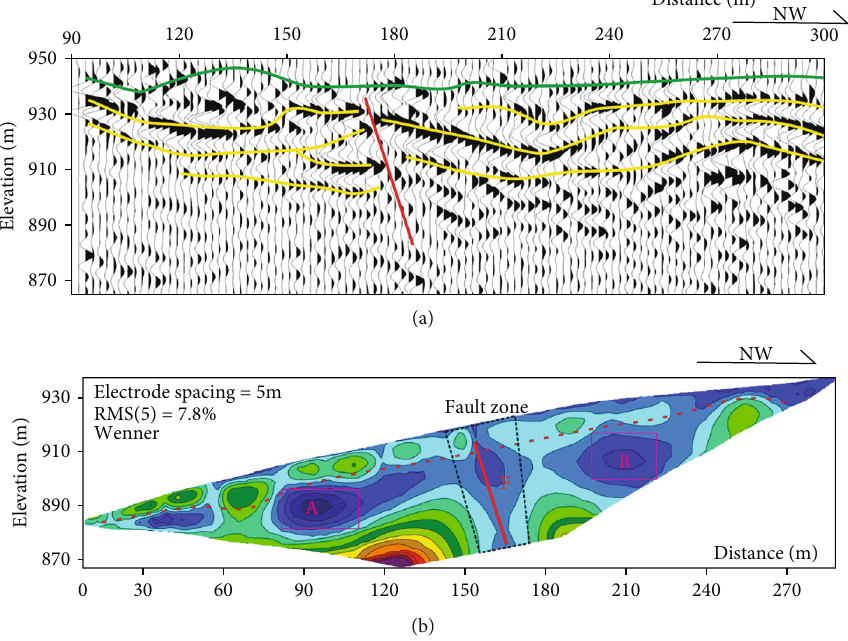
Figure 5: Faults in a time pro fi le and in an electrical resistivity tomography [53].